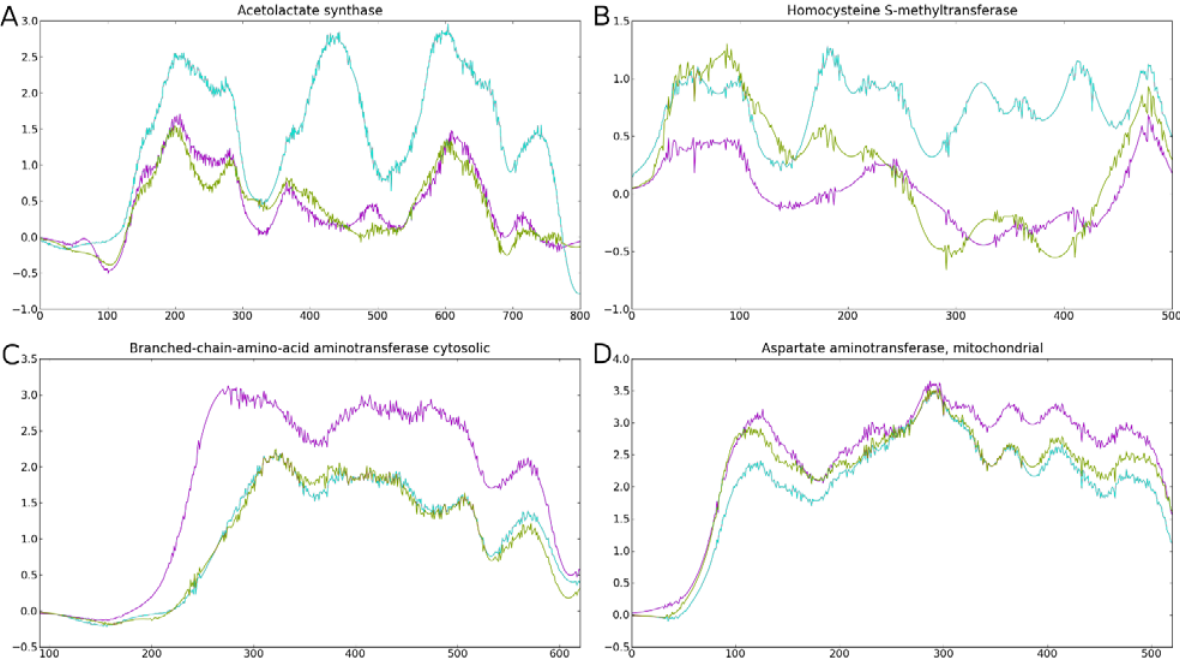
Figure 2. Amino acid conservation between clades for four ReGens. Lines are colored according to the clade comparison code defined in Figure 1B. Pairwise comparisons of proteins from each clade were plotted along their multiple alignment extension ( x -axis). Higher values ( y -axis) represent more similar regions in the interclade comparison. The y -axis represents the proportion of amino acid substitutions in a given position of the multiple alignments ( x -axis); positions with gaps were removed. ( A ) ALS; ( B ) BHMT; ( C ) BCA; ( D )